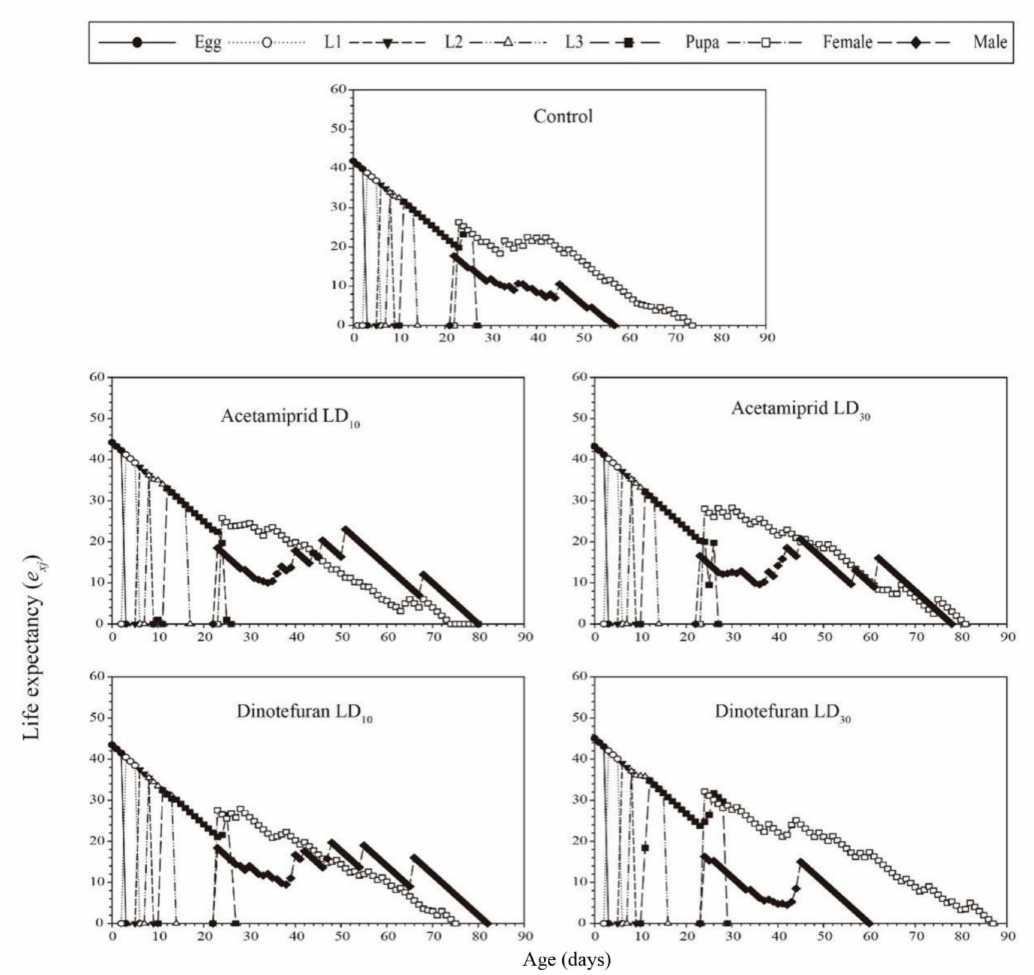
Figure 4. Life expectancy ( e xj ) values for 2nd instar C. pallens larvae exposed to sublethal acetamiprid and dinotefuran